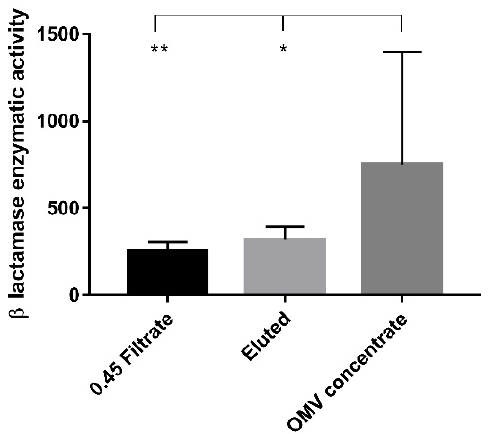
Figure 3. β -lactamase enzymatic activity. The bar graph shows the β -lactamase enzymatic activity expressed in milliunits/milligram of protein (mU/mg) measured in the three experimental conditions. Each value was normalized to the protein content and expressed as means ± standard deviation. Asterisks indicate significant differences in the β -lactamase activity. * p < 0.05, ** p < 0.01.